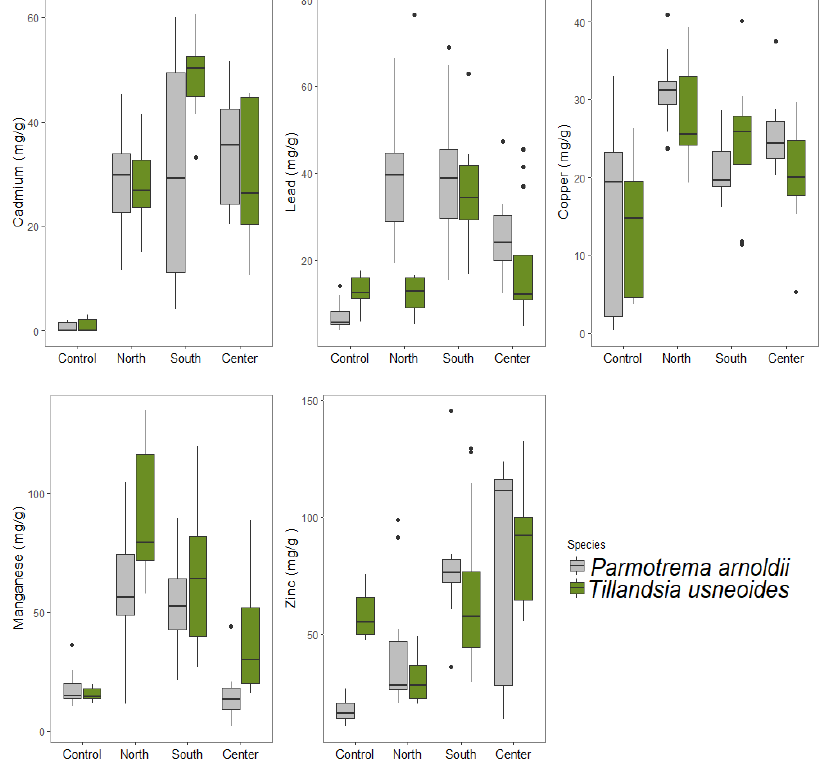
Figure 3. Box plot of metal (Cd, Pb, Cu, Mn and Zn) concentrations (mg/g) in Parmotrema arnoldii and Tillandsia usneoides , for air quality in different study areas. Boxplots showing the outliers (black circles).